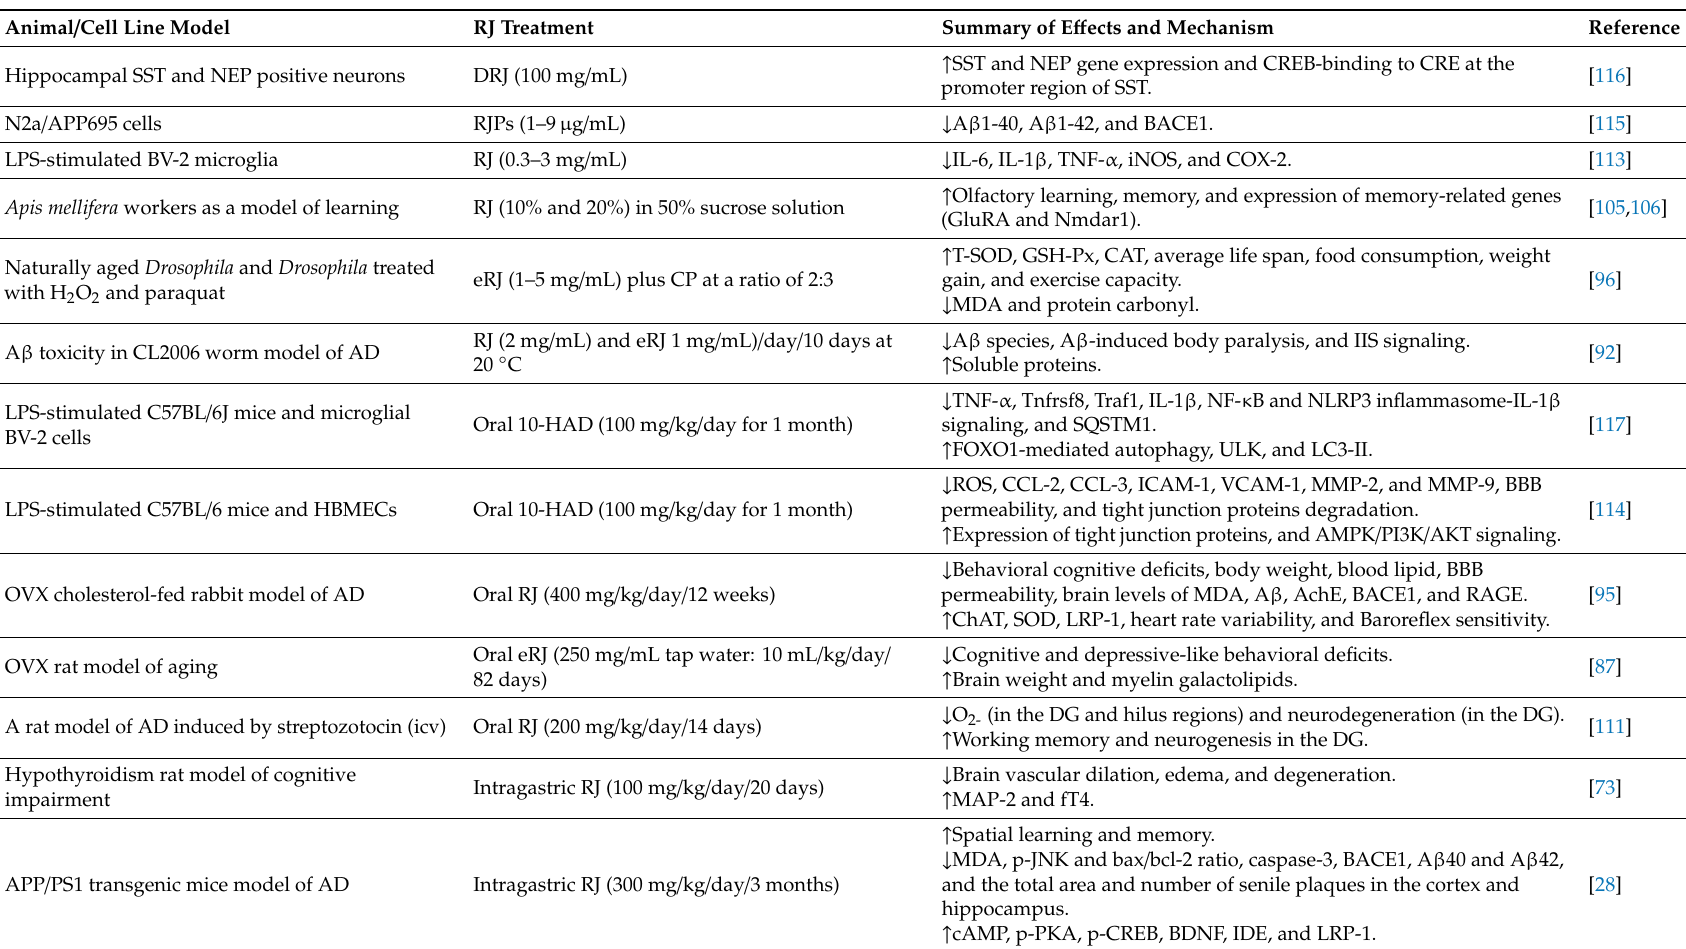
Table 2. E ff ects of royal jelly on cognition and related molecular-level changes in experimental models and humans (N of reviewed studies =